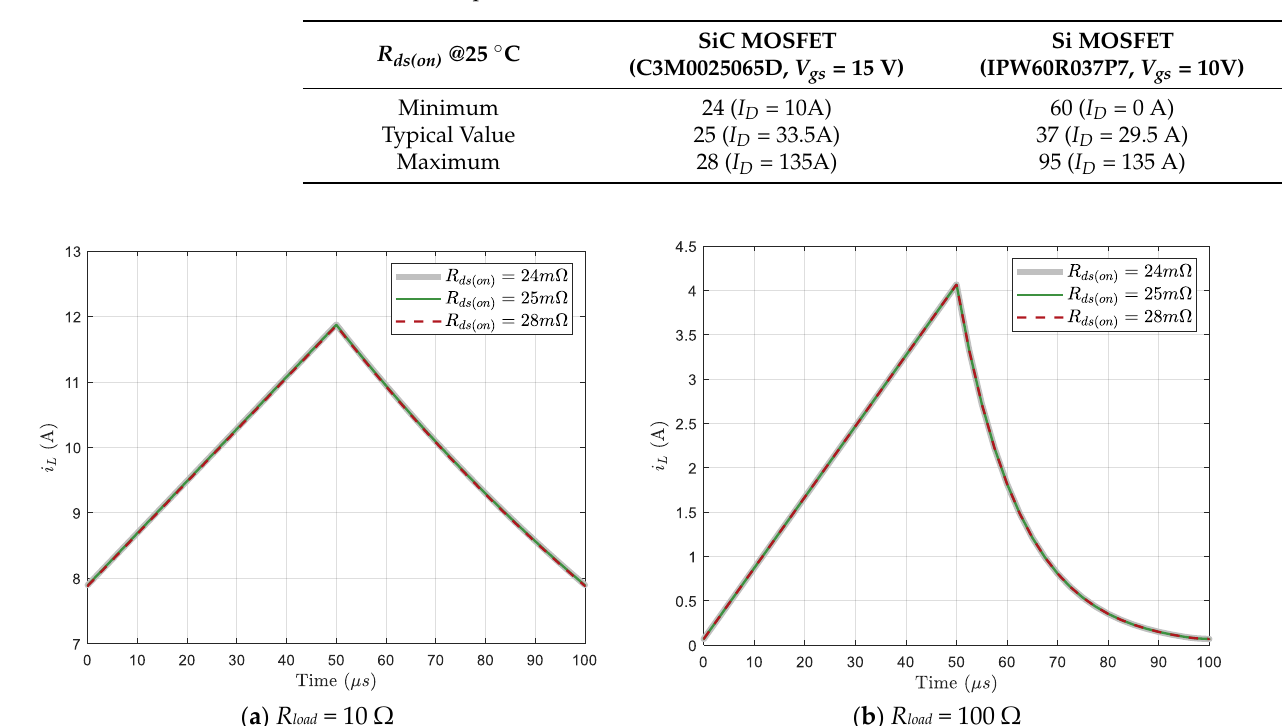
Figure 12. Simulation results: ( a ) when R load = 10 Ω , and ( b ) R load = 100 Ω. Figure 11. Simulation results: ( a ) when R load = 10 Ω , and ( b ) R load = 100 Ω Table 2. The comparison between SiC and Si MOSFETs.